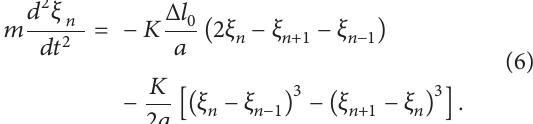
Figure1:Transverseoscillationsofequalmassparticlesinanatomic